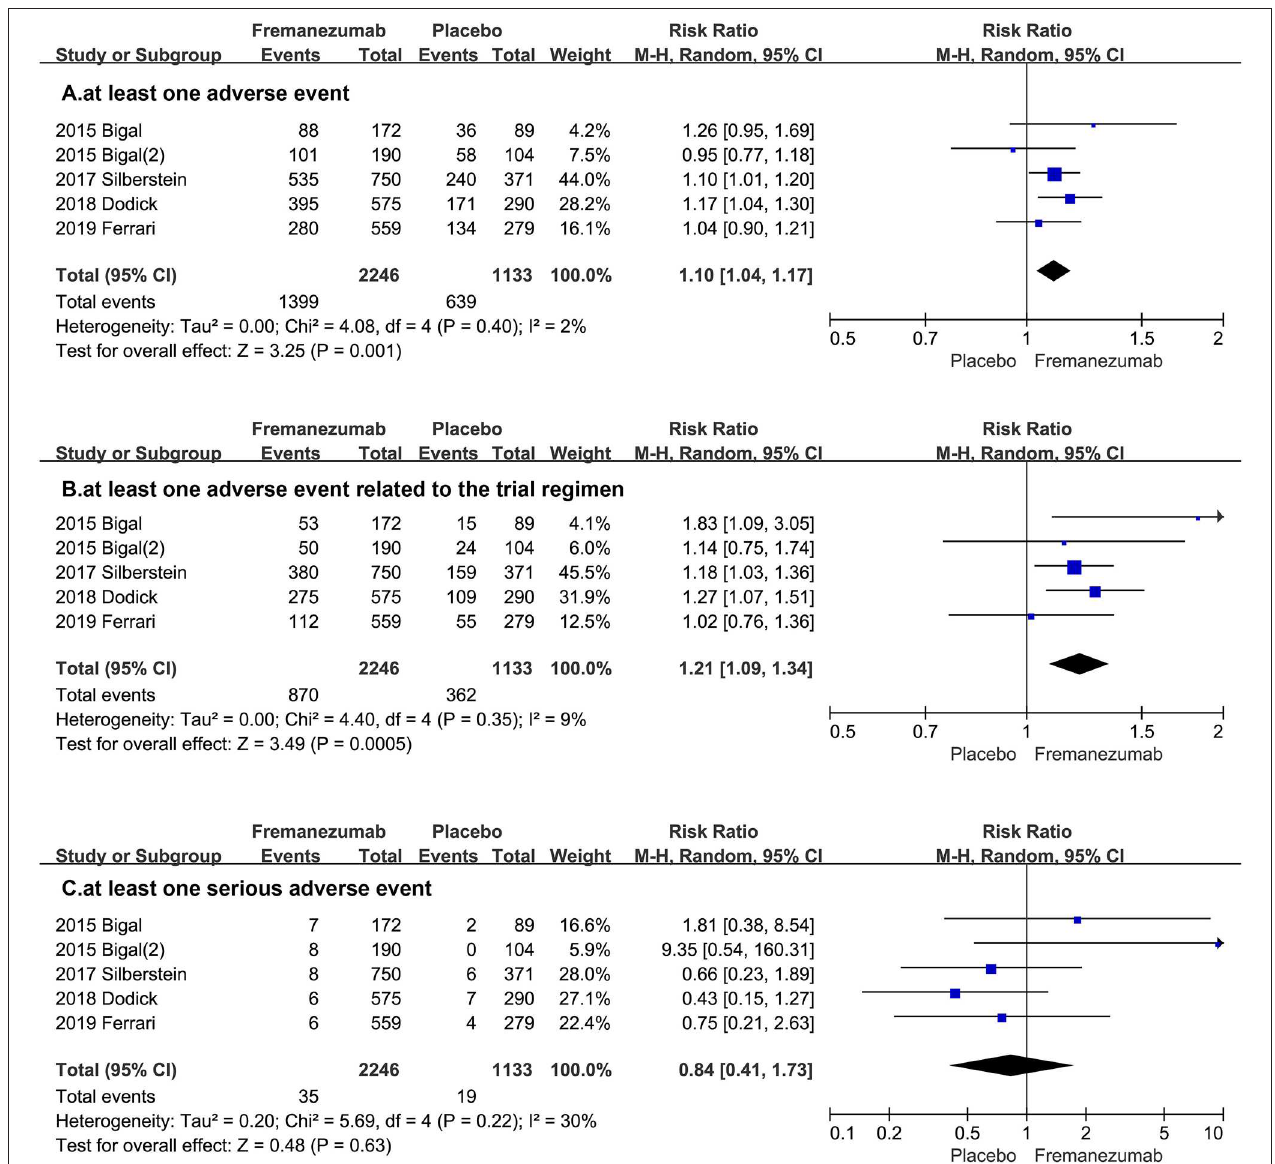
FIGURE 3 | The pooled RR of adverse events. The blue square indicates the estimated RR for each RCT. The size of blue square indicates the estimated weight of each RCT, and the extending lines indicate the estimated 95% CI of RR for each RCT. The black diamond indicates the estimated RR (95% CI) for all patients together. (A) at least one adverse event. (B) at least one adverse event related to the trial regimen. (C) at least one serious adverse event. CI, confidence interval; RCT, randomized controlled trial; RR: risk